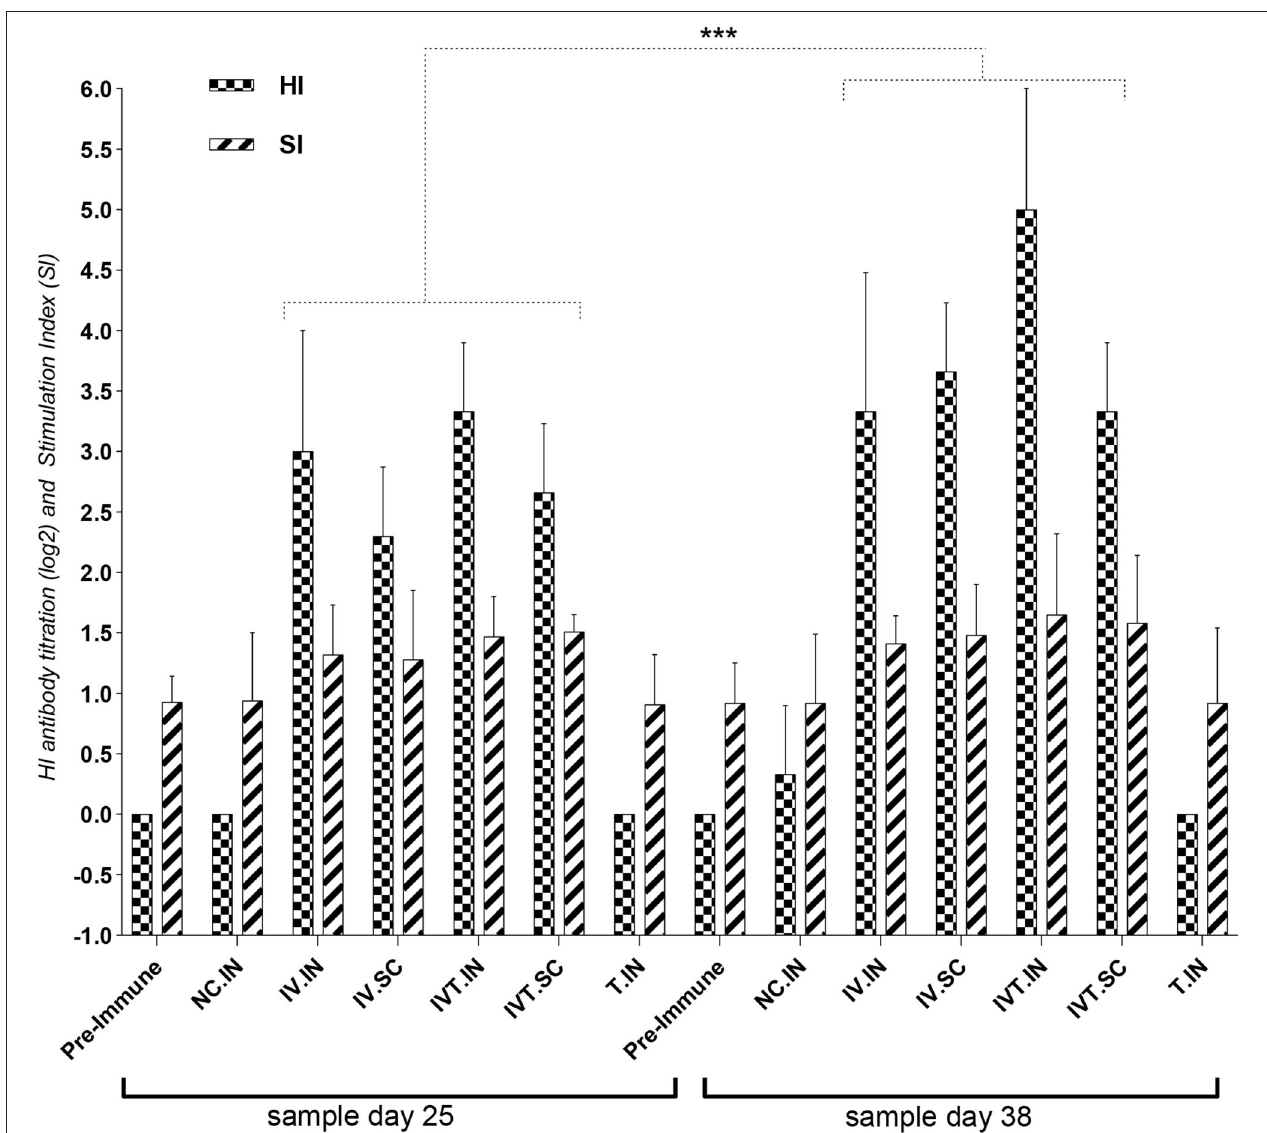
FIGURE 3 | The first design for the chicken experiment, evaluation of HI antibody titration and Stimulation Index (SI) for Splenic Lymphocyte Proliferation Assay for vaccinated chicken groups. N.C, negative control; IV, Irradiated Vaccine; IVT, Irradiated Vaccine + Trehalose; IN, Intranasal; SC, Subcutaneous; Adm, Administration. *** P ≤